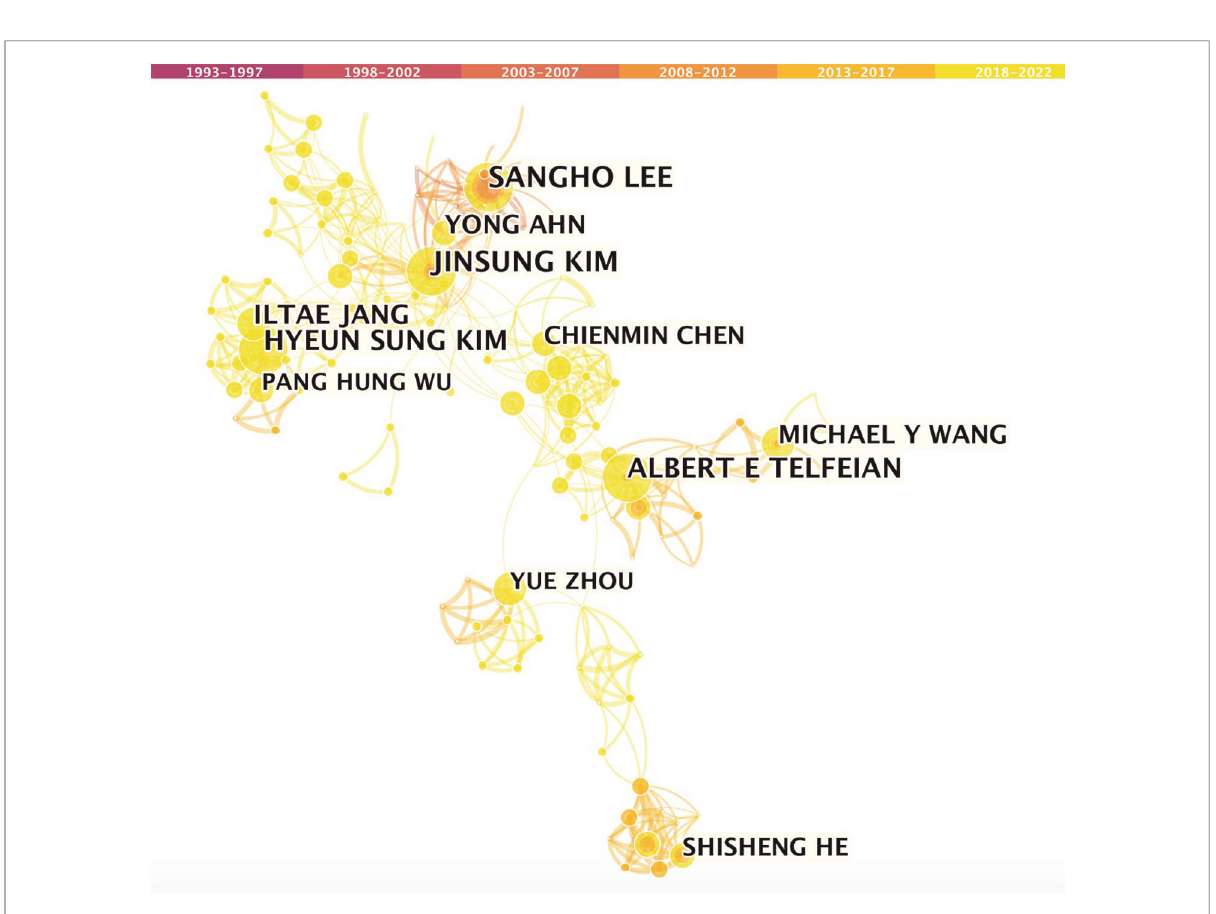
FIGURE 4 Co-operation network of productive